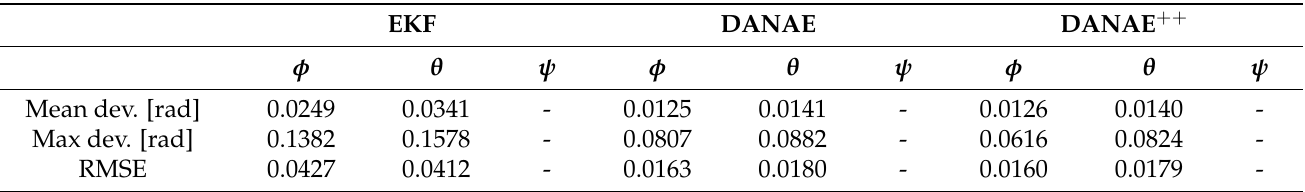
Figure 6. UCS Dataset: theta angle estimation provided by the EKF (top, light brown) and DANAE ++ (bottom, light blue) compared to the GT (dark red). This experiment was performed on a subsection of the slow walking set. Table 5. UCS Dataset: evaluation of the performances of the EKF, DANAE and DANAE ++ w.r.t. the GT for the three Euler angles. Since the GT values of ψ are not reliable, the corresponding results are not reported